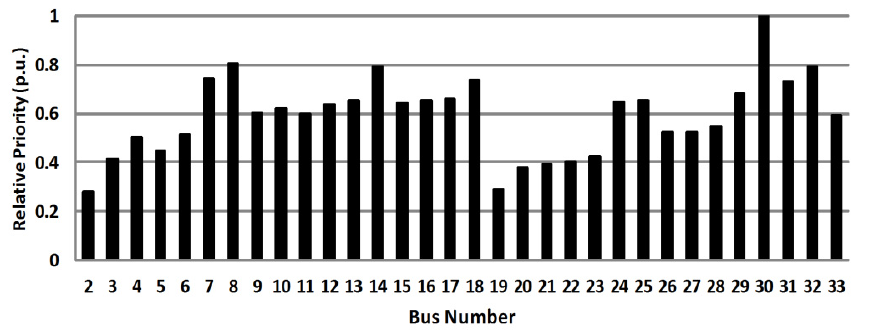
Figure 6. FAHP bus Figure 6. FAHP bus ranks.